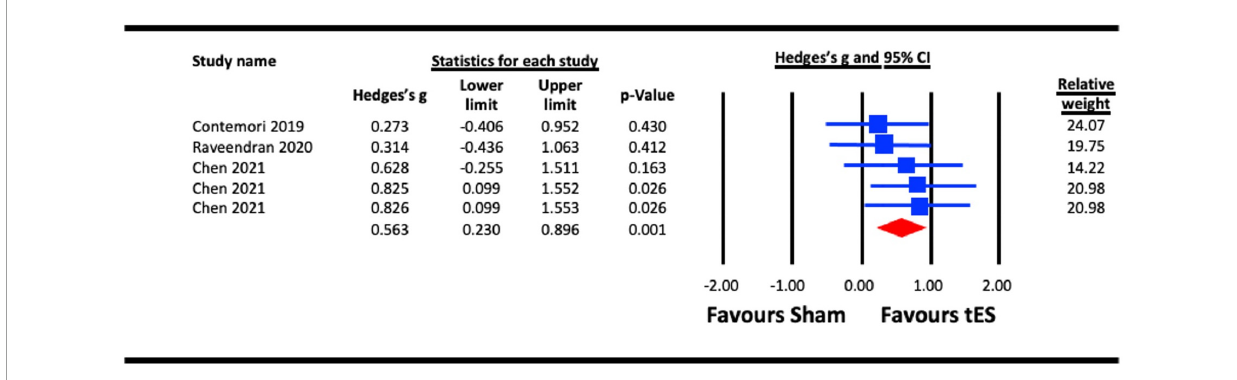
FIGURE6 Acute effect of transcranial electrical stimulation (tES) [anodal-transcranial direct current stimulation (a-tDCS) and transcranial random noise stimulation (tRNS)] on crowding. Chen (2021) (each line represents the outcome of experiments 1–3).